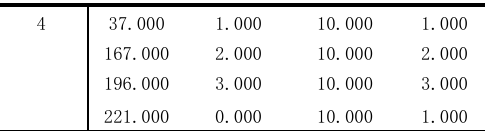
Fig.6 FPGA implementation of wideband digital receiver